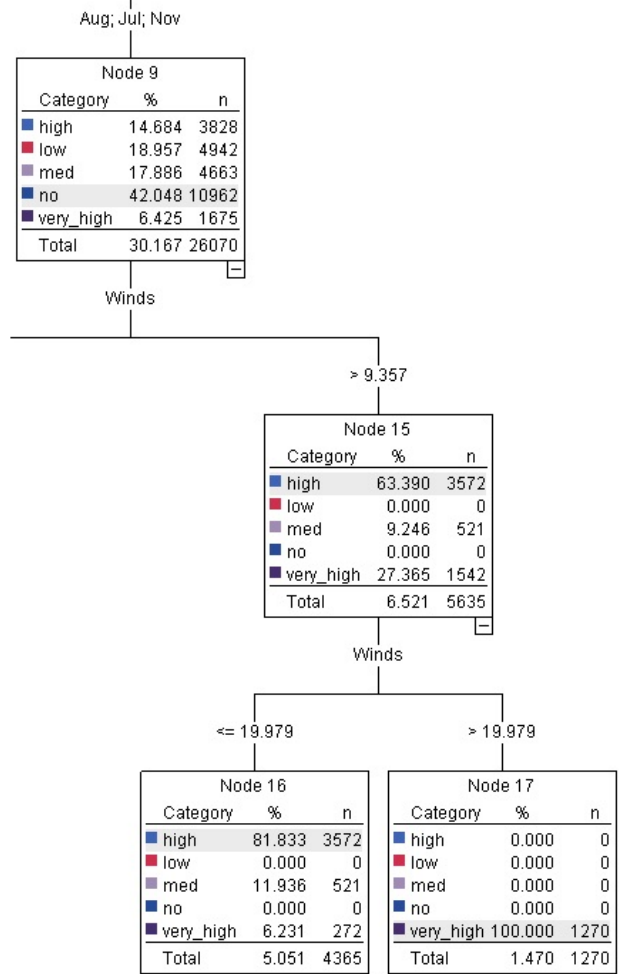
Figure 2. QUEST tree rules relating to very high gusts.